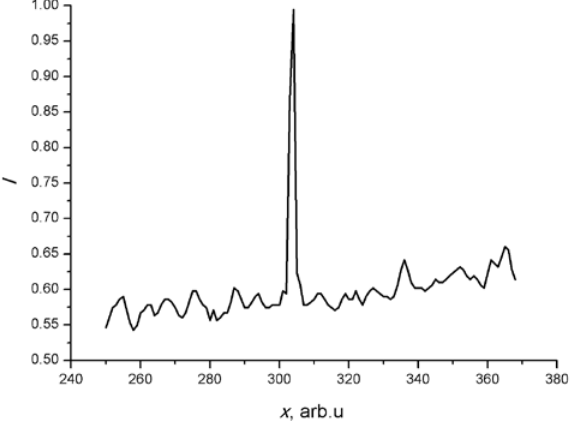
Fig. 3. Normalized inverted profile photometric data of one structural element of the groove type (1 arb.u. ≈ 400